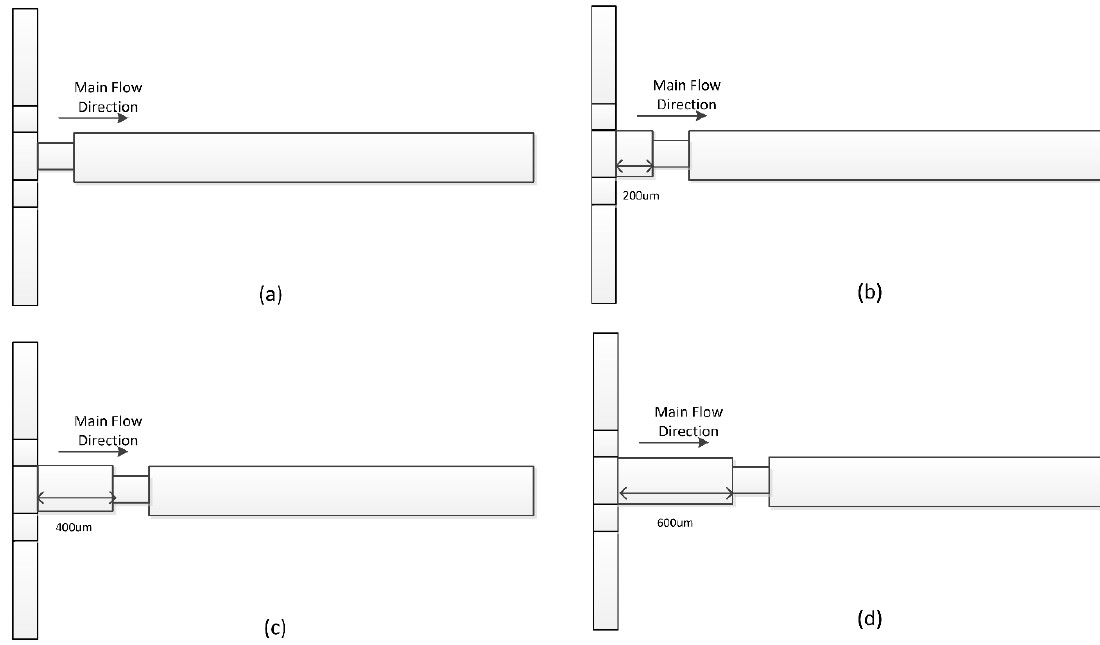
Figure 13. Schematics of ( a ) TMSC, ( b ) TMSC1, ( c ) TMSC2, ( d ) TMSC3.